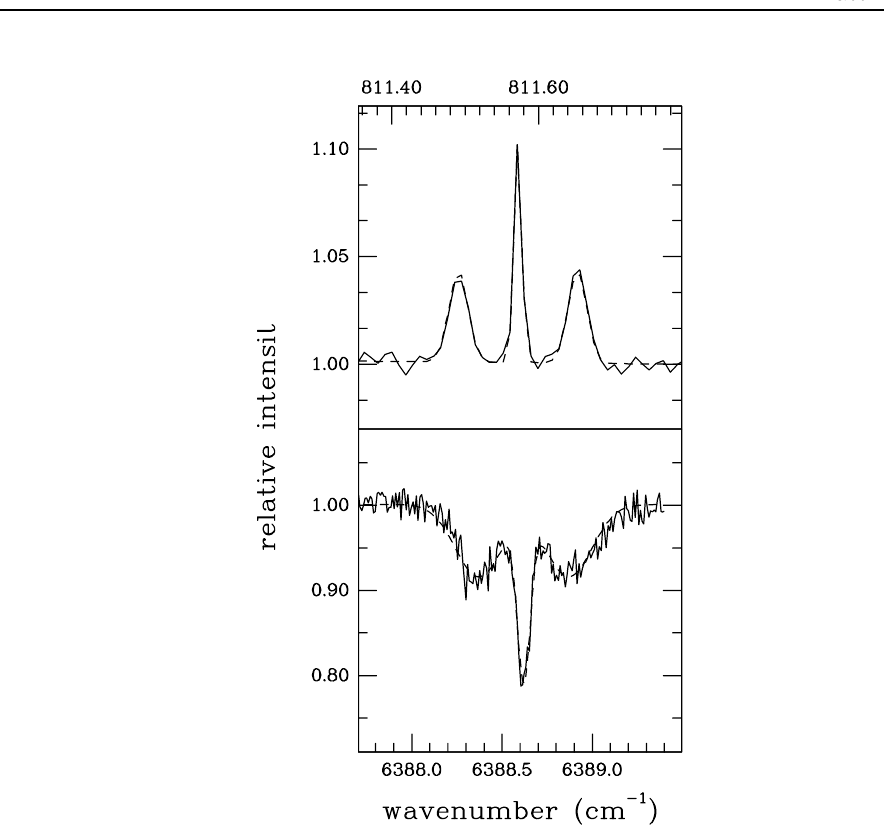
Figure 15: Simultaneous spectra from a sunspot umbra showing the Mg i 12318 nm (top) and the Fe i 1565 nm (bottom) lines. The larger splitting of the Mg i line components is clearly visible, and the width of the Zeeman shifted components reveals a large range in the magnetic field strengths seen at this spatial position. Image reproduced with permission from Moran et al. (2000), copyright by